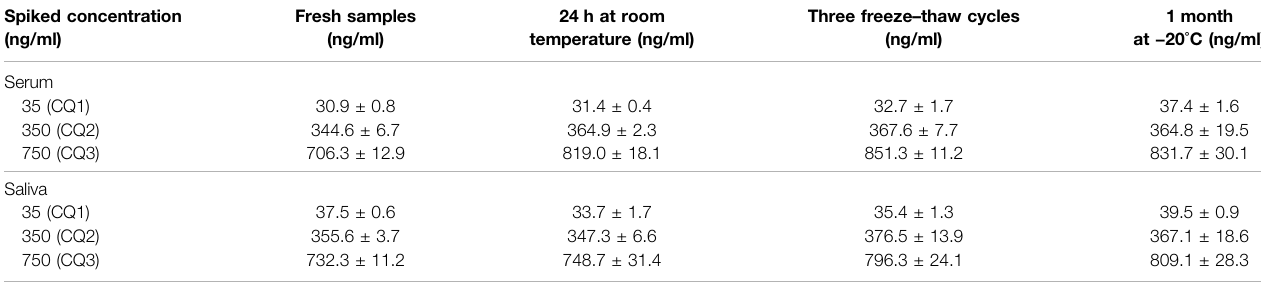
TABLE 4 | Stability of CBD in human serum and saliva under different storage conditions. Spiked concentration (ng/ml)